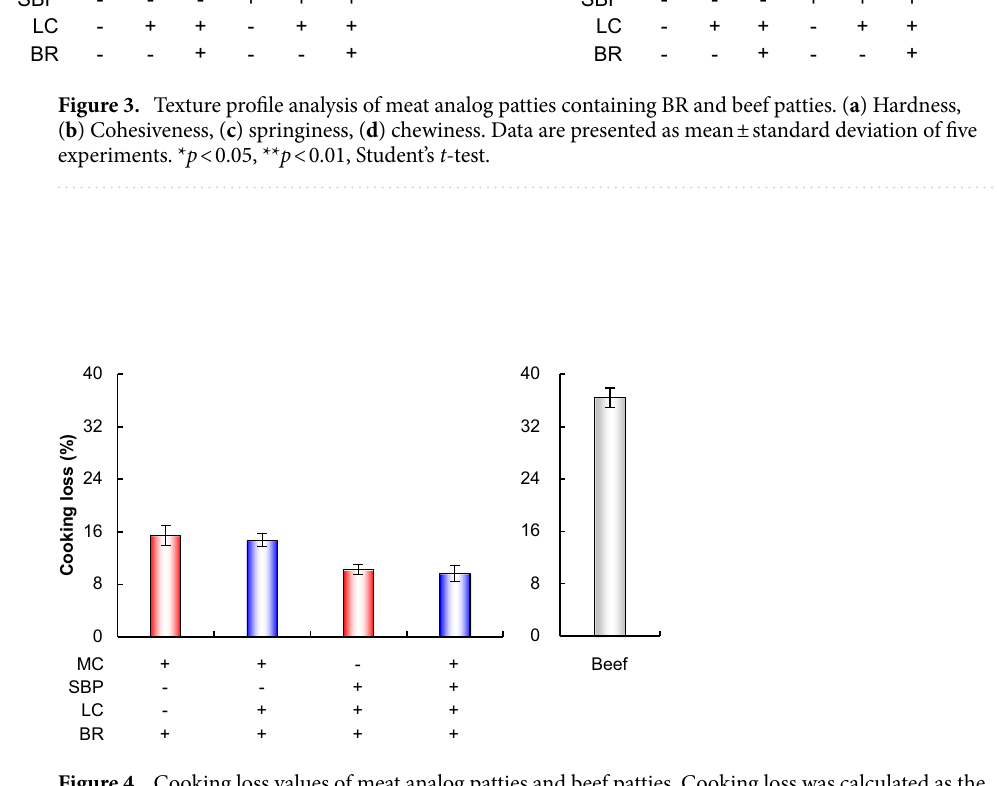
Figure 4. Cooking loss values of meat analog patties and beef patties. Cooking loss was calculated as the percentage weight difference between the dough before and after grilling. * p < 0.05, Student’s t